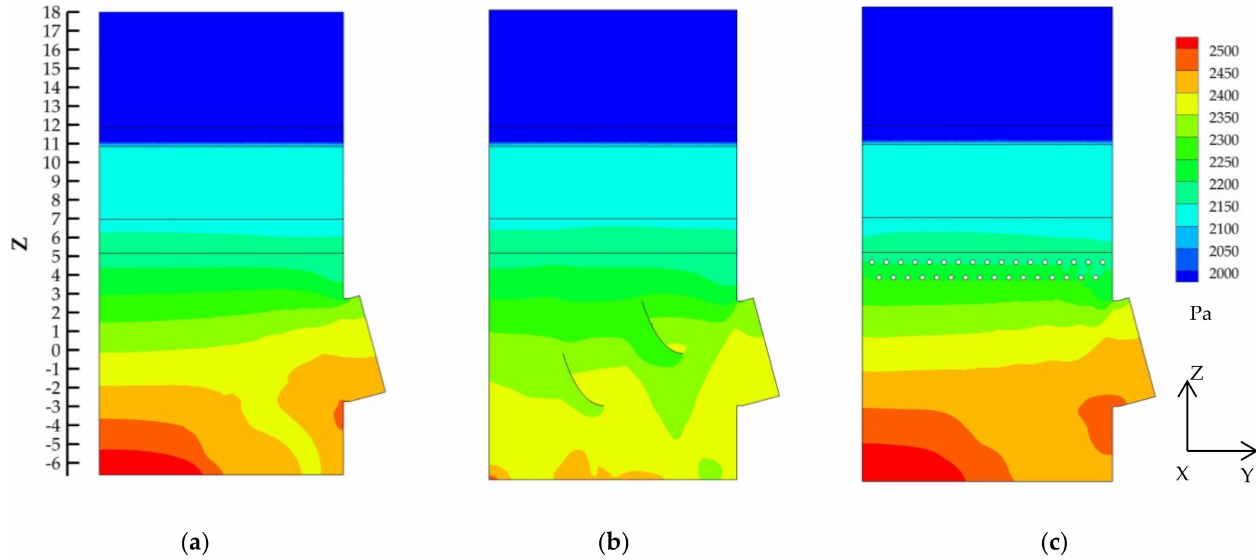
Figure 13. Pressure distribution at X = 0 plane: ( a ) OST; ( b ) DST; ( c ) RBST.